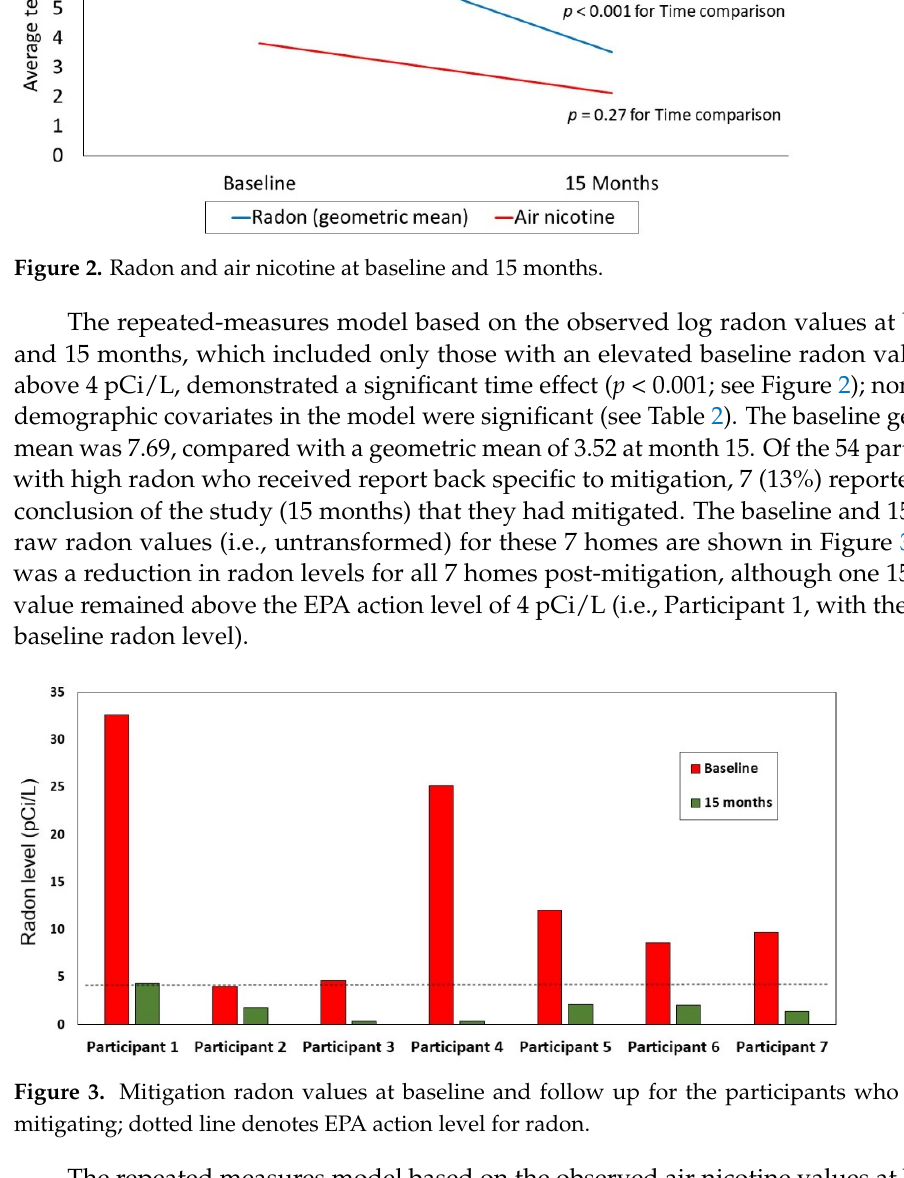
Figure 3. Mitigation radon values at baseline and follow up for the participants who reported miti-